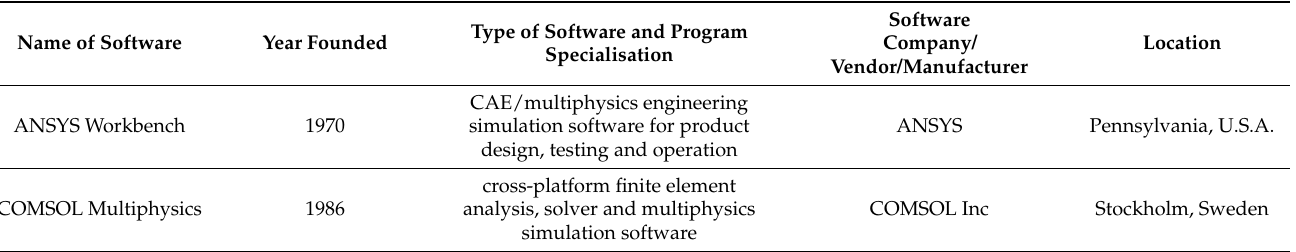
Table 4. Table of some structural software programs, and computer-aided design (CAD) software programs with developer